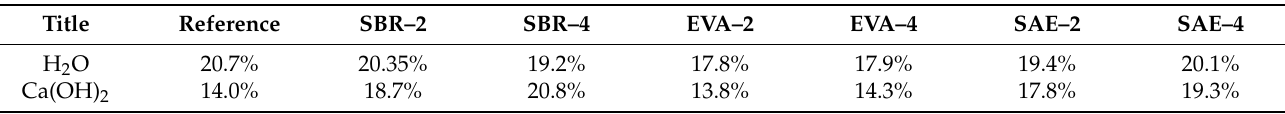
Table 4. Influence of polymer latex on amount of bound water and portlandite content in hydration